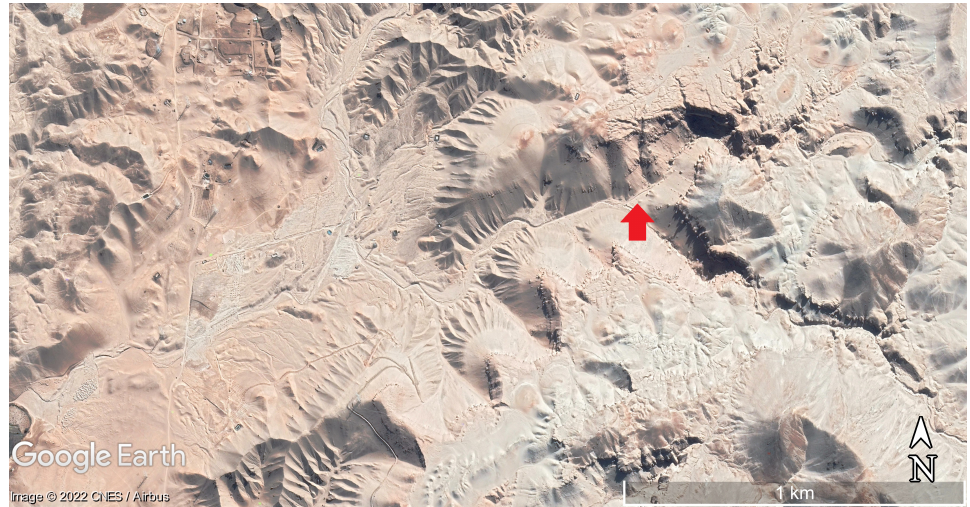
Figure 6. Rio Muerto sub-basin; 2020 satellite image (17 ◦ 17 (cid:48) 58 (cid:48)(cid:48) –17 ◦ 18 (cid:48) 45 (cid:48)(cid:48) S, 70 ◦ 59 (cid:48) 11 (cid:48)(cid:48) –70 ◦ 57 (cid:48) 34 (cid:48)(cid:48) W). The sample point of the Miraflores Unit [51] is indicated by the red arrow (see text). Upstream, the cracked hill-slope area of regolith production may be